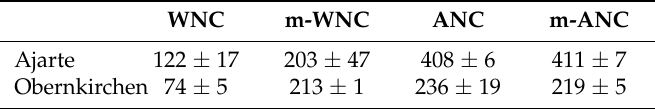
Table 4. Volume of liquid treatments ( µ L/cm 2 ) absorbed by Ajarte and Obernkirchen stones. Values are averaged on 3 specimens.